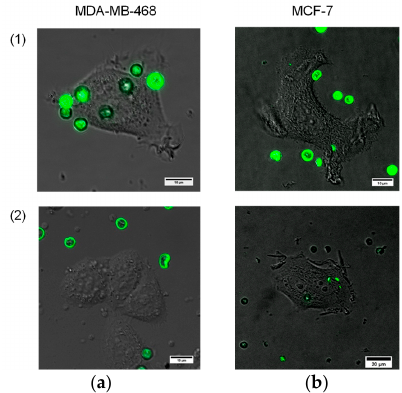
Figure 5. Images of individual cancer cells or their groups interacting with the QD-encoded microcapsules ((1) antibody-functionalized microcapsules; (2) bovine serum albumin-coated microcapsules): ( a ) MDA-MB-468 human breast adenocarcinoma cells; ( b ) MCF-7 human breast adenocarcinoma cells.